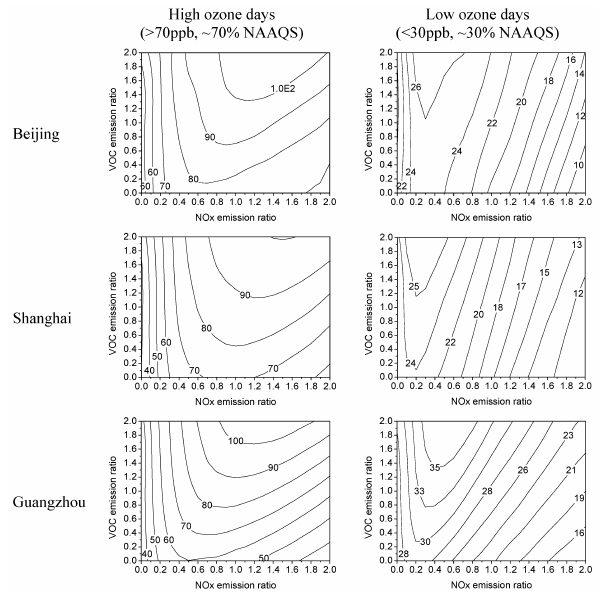
Fig. 10. Averaged ozone isopleths for high and lower ozone days in three